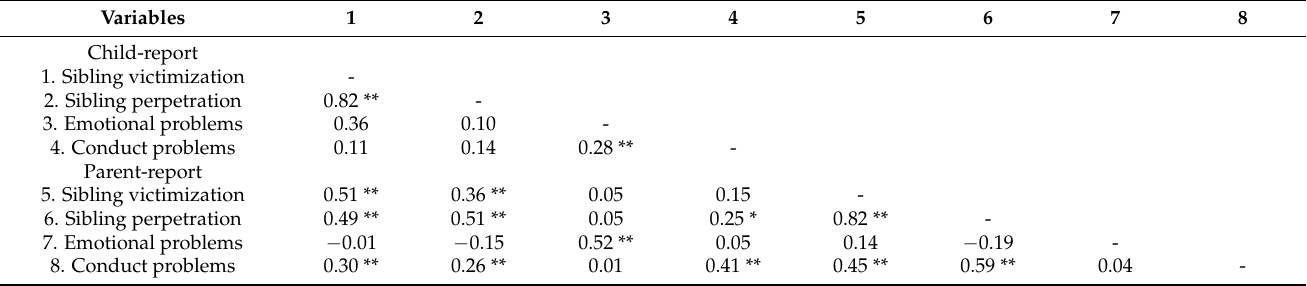
Table 2. Intercorrelations of key study variables across the sibling subsample ( n =